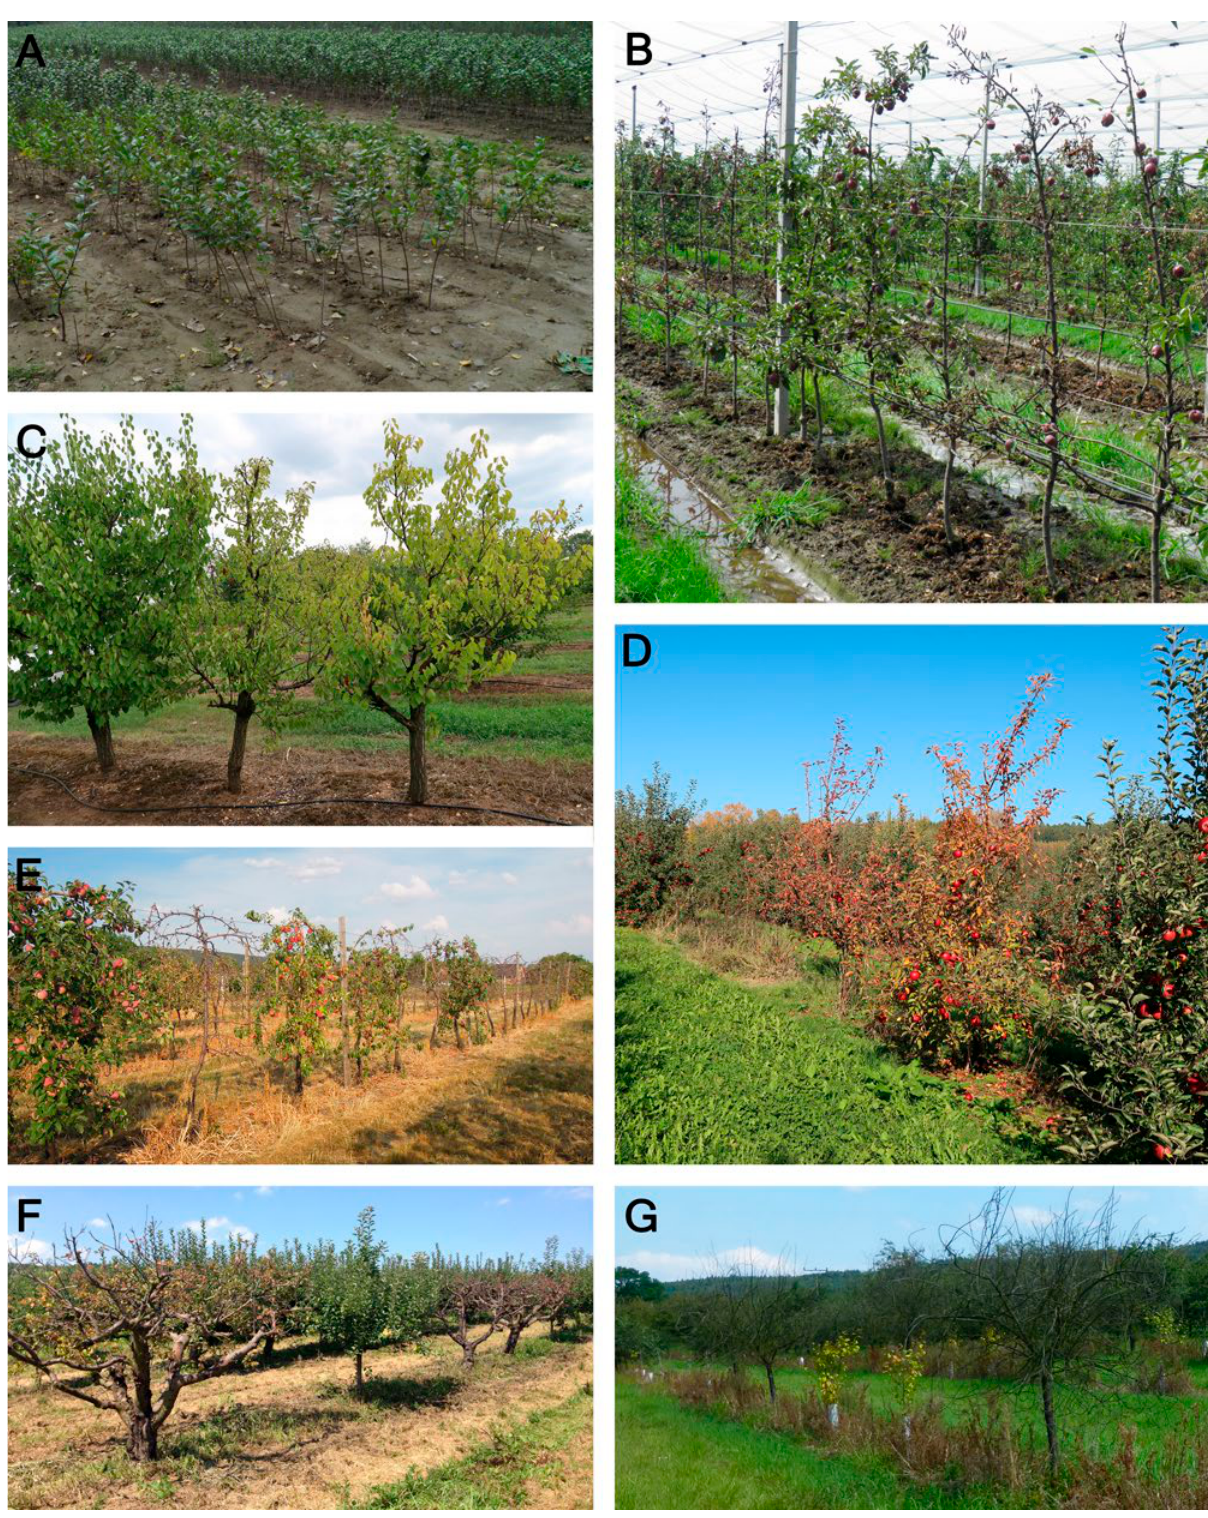
Figure 2. Characteristic damage of Malus domestica fruit nurseries and orchards (A, B, D–F) and Prunus domestica (C, G): A, yellow foliage of infected seedlings, B, an excess of water promoted the disease caused by P. chlaymdospora × amnicola in a young orchard; C, new disease outbreaks are apparent due foliage yellowing; D, premature leaf senescence and shedding of infected trees; E, characteristic disease focus in an orchard row; F, killed mature trees; G: attacked replanting in a damaged